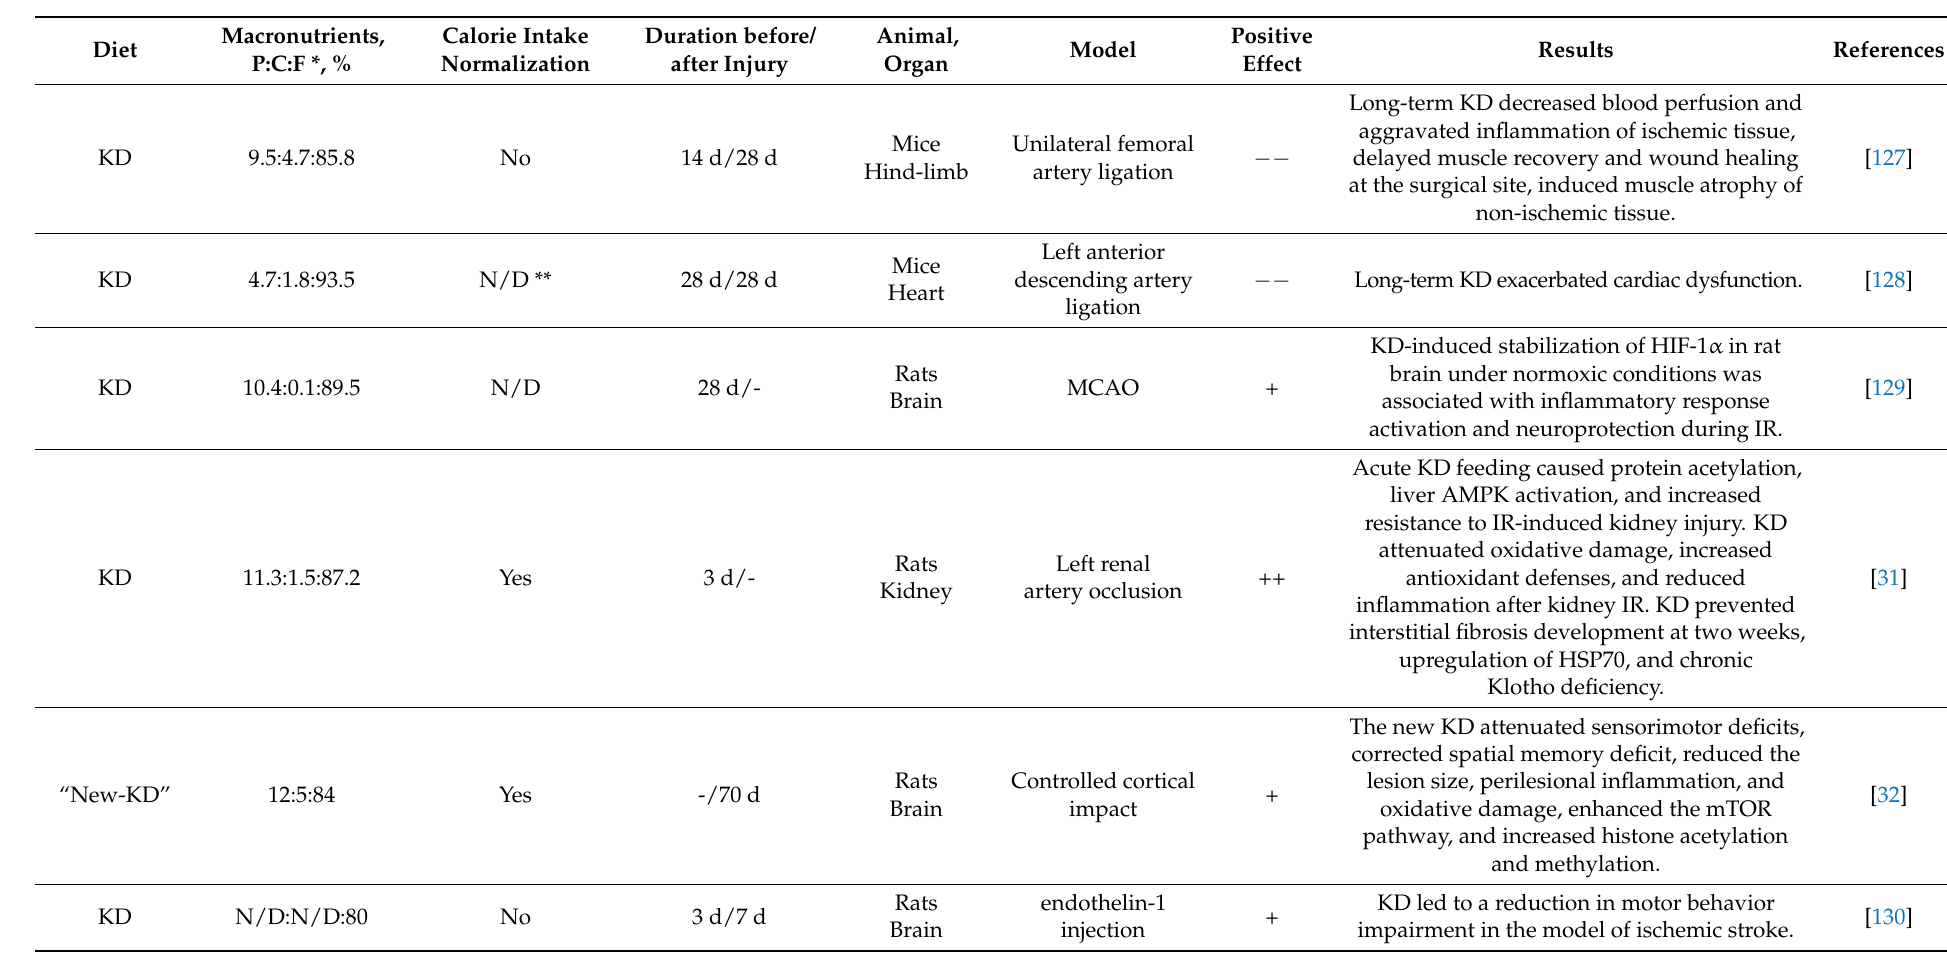
Table 1. Studies related to the usage of KD or similar diets against IR